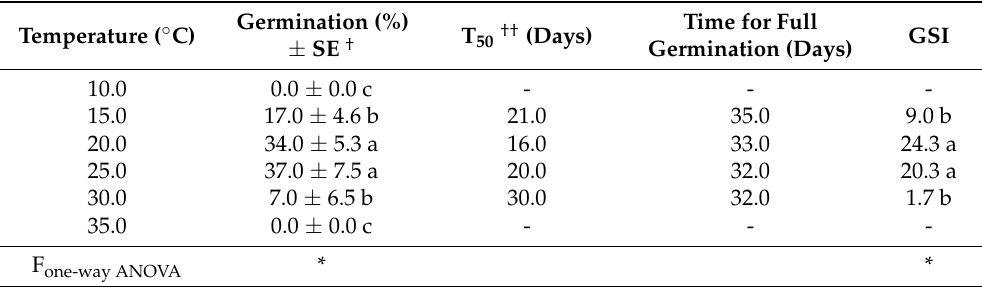
Table 1. In vitro germination of Sideritis raeseri subsp. attica seeds, T 50 , times for full germination, and germination speed indexes (GSI) at the temperatures shown.